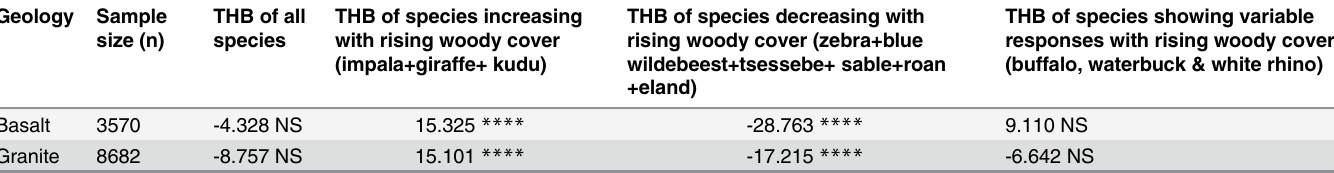
Table 3. Slope coefficients of average Total Herbivore Biomass (THB) (kg.km -2 ) along an increasing woody cover gradient (20 – 65%) ( **** 0.01% significance level; *** 0.1% significance level; ** 1% significance level; * 5% significance level; NS non-significant). The slope coefficients were calculated for all species combined (column 3), as well as for subsets of species based on whether they increase (column 4), decrease (column 5) or have variable responses (column 6) along a gradient of increasing woody cover. Note how the slopes are not significantly different from zero when considering all species combined (column 3), as opposed to highly significant positive (column 4) and negative (column 5) slopes for the suits of species increasing and decreasing respectively along a gradient of increasing woody cover. This illustrates that although herbivore biomass will get partitioned differently between species with increasing woody cover, the total herbivore biomass when considered across all species will remain constant between 20 – 65% woody cover. Geology Sample THB of all THB of species increasing THB of species decreasing with THB of species showing variable size (n) species with rising woody cover rising woody cover (zebra+blue responses with rising woody cover (impala+giraffe+ kudu) wildebeest+tsessebe+ sable+roan (buffalo, waterbuck & white +eland)